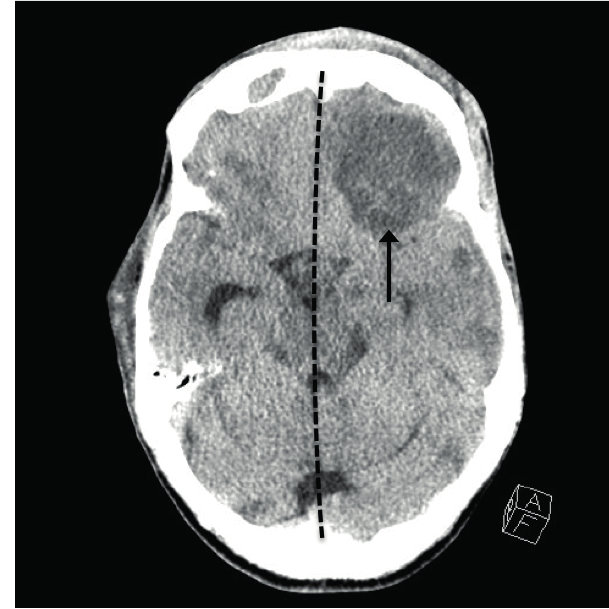
Figure 4. Axial CT scan (at acute and second admission) illustrating a left- sided subdural empyema 45x42mm (arrow) and midline shift (dotted